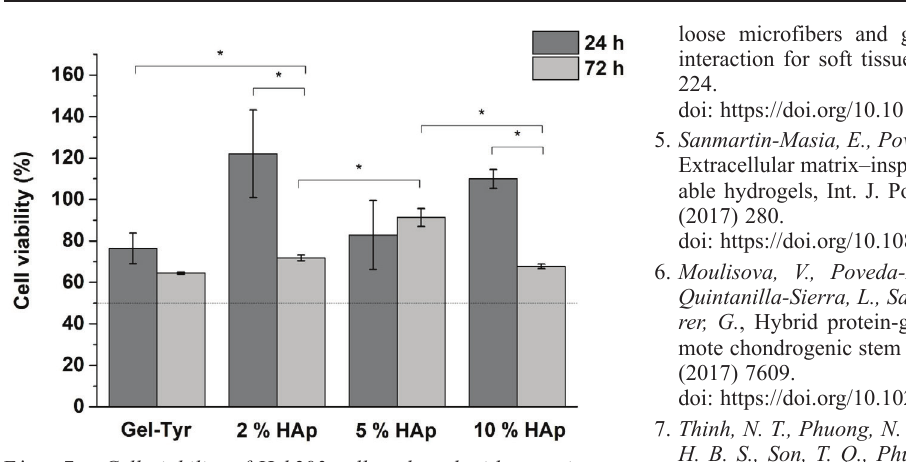
Fig. 7 – Cell viability of Hek293 cells cultured with materi- al’s supernatant after 24 and 72 h of culture. The significant difference between two groups is denoted by asterisk (*) with p < 0.05. 50 % of cell viability is defined as a lower limit of